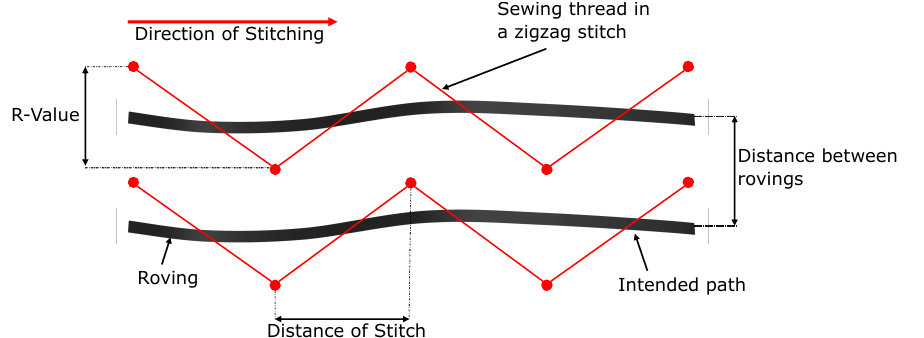
Figure 4. Stitching parameters where the black lines and red lines correspond to the rovings and the sewing thread, respectively.